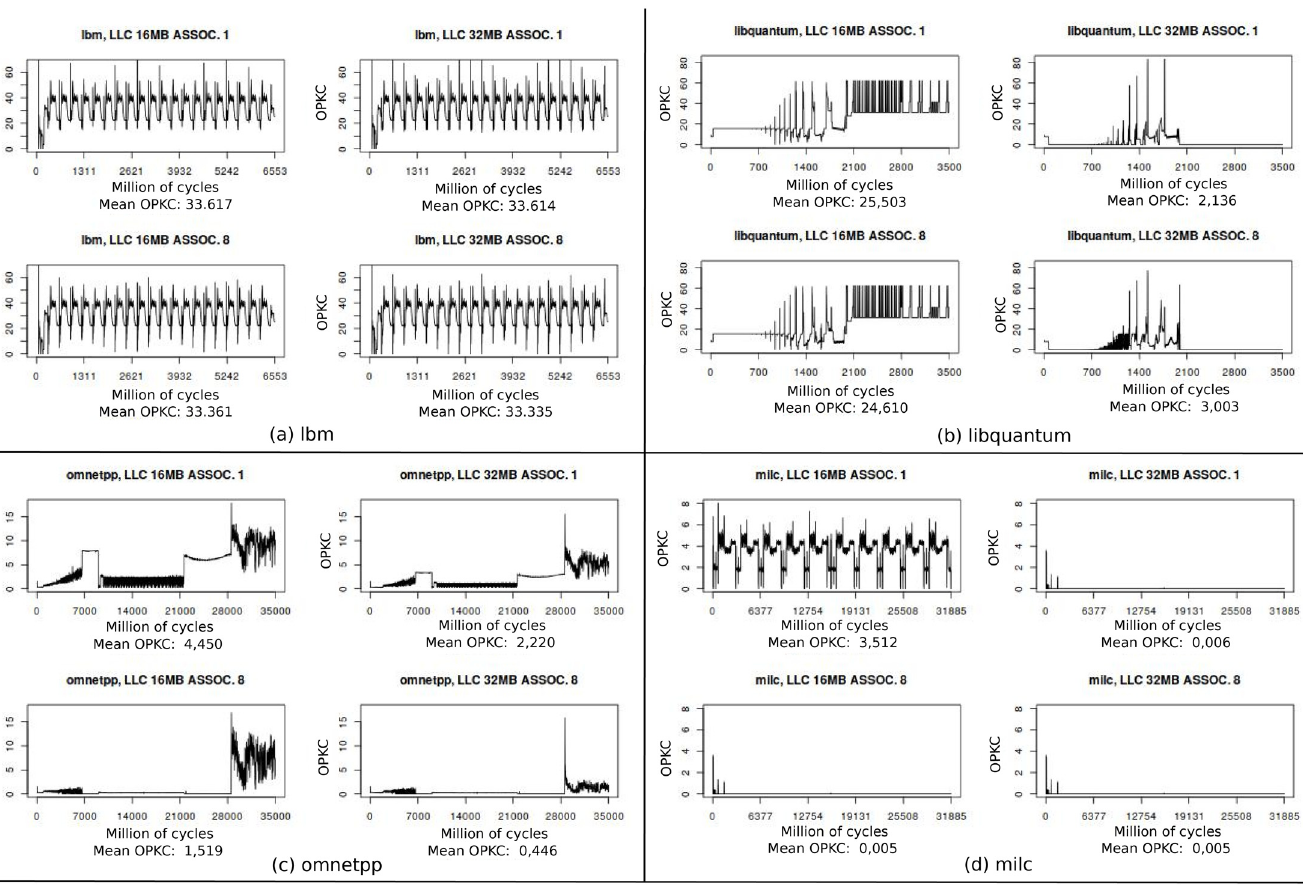
Fig 4. Frequency analysis with four LLC configurations. In this figure we use off-chip OPKC to describe the types of misses related to LLC size and associativity. lbm OPKC is independent of LLC configurations, libquantum misses reduce with LLC size so they are capacity type, omnetpp misses diminish when associativiy increases so they are conflict type and, finally, milc has both